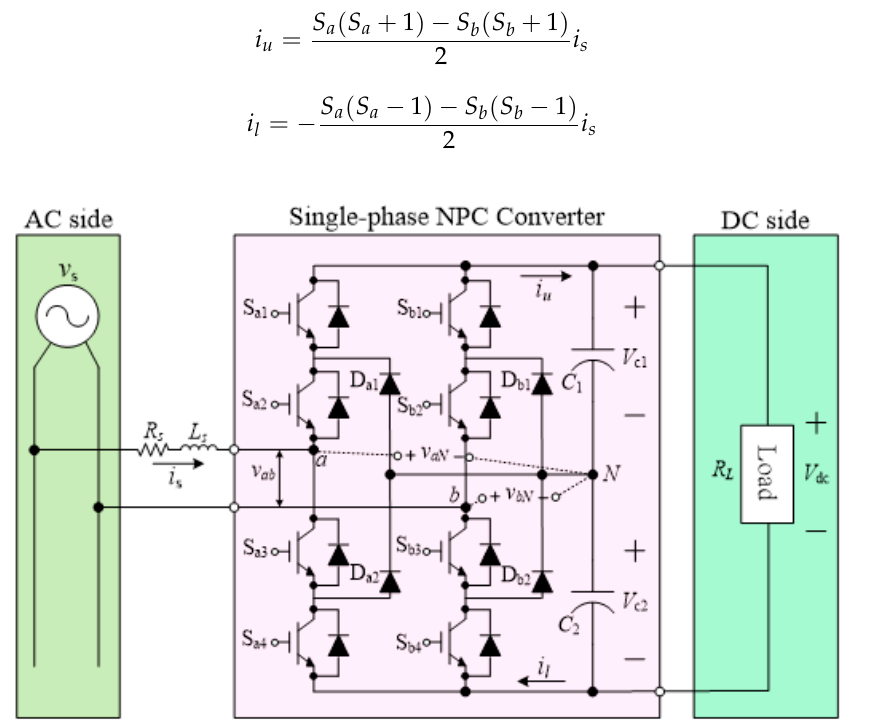
Figure 1. Single-phase three-level NPC